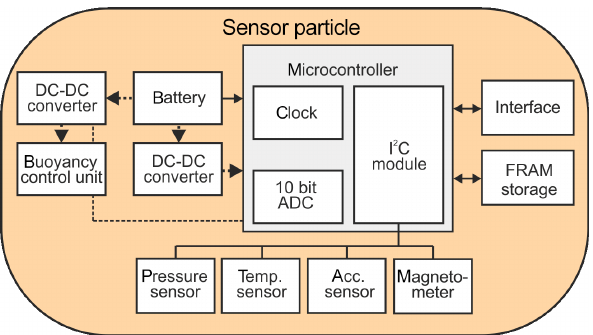
Figure 1. Components of a sensor particle with internal electronics and buoyancy control unit.